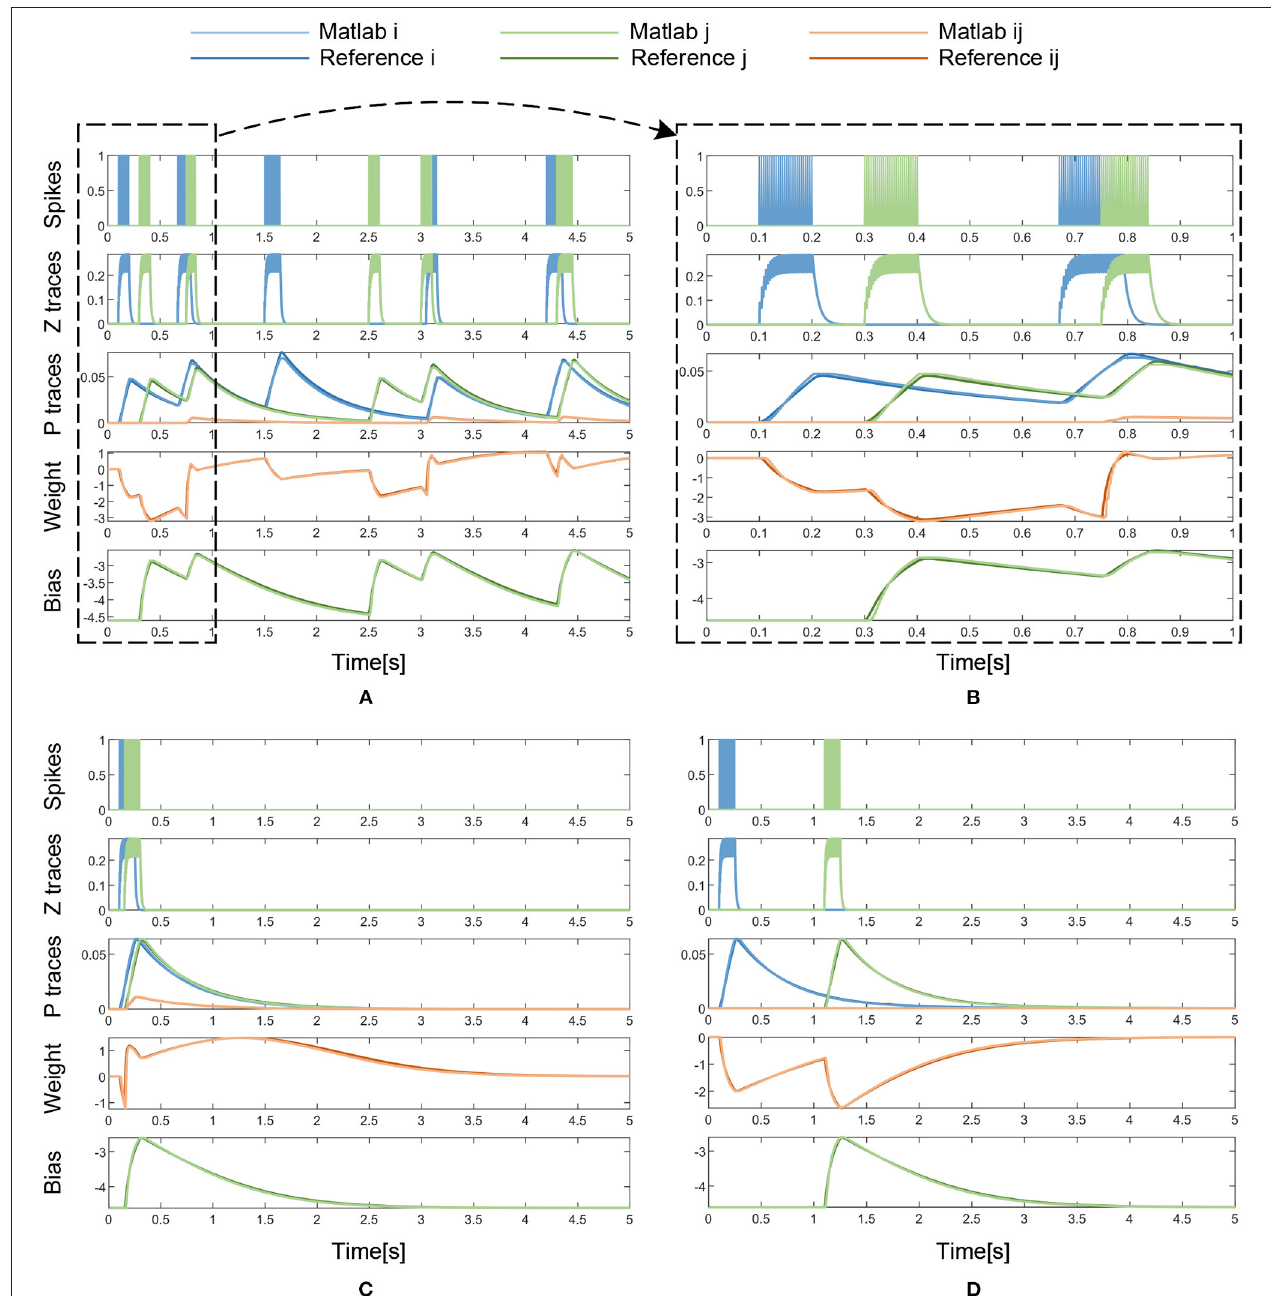
FIGURE 9 | Matlab simulation results with dense or sparse incoming spikes. (A) Dense Spikes: 5-s simulation. (B) Dense Spikes: 1-s simulation. (C) Sparse Spikes: presynaptic spike train S i overlaps with postsynaptic spike train S j . (D) Sparse Spikes: presynaptic spike train S i is seperated with postsynaptic spike train S j .